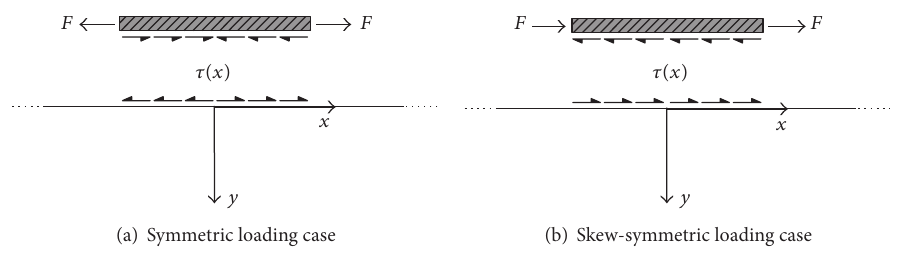
(b) Skew-symmetric loading case Figure 2: Loading cases.